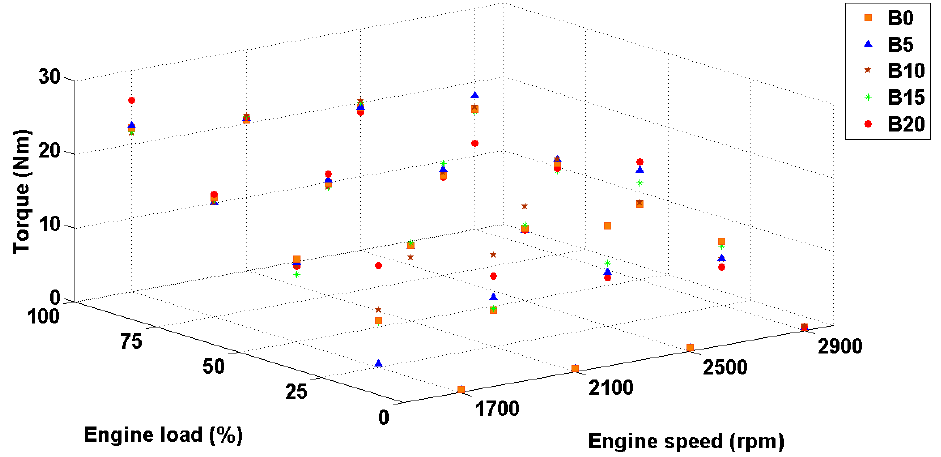
Figure 6. Torque of the engine under different engine loads, speeds and biodiesel percentages.